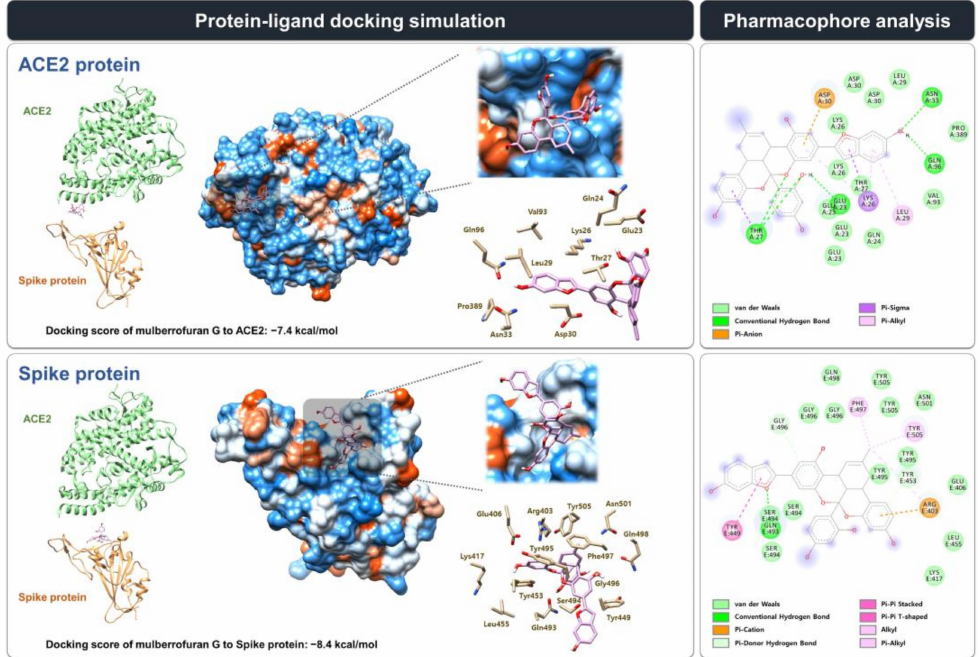
Figure 3. Protein–ligand docking simulation between mulberrofuran G (MG) and the ACE2 recep- tor/spike protein. MG docking onto the SARS-CoV-2 spike protein and ACE2 receptor (PDB code 6M0J) was simulated using AutoDock Vina. The pharmacophore analysis of MG with the spike protein or hACE2 receptor was performed using BIOVIA Discovery Studio